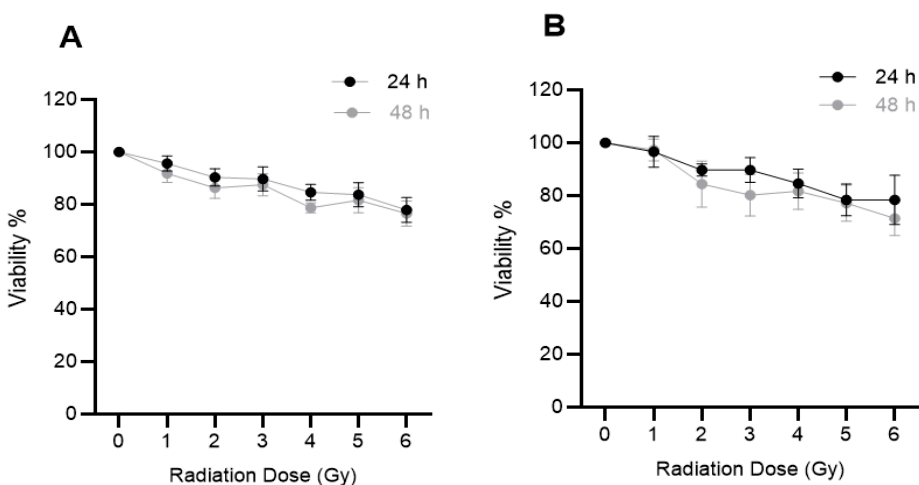
Figure 3. E ff ect of ionizing radiation (IR) on the viability of human cancer cells in vitro. ( A ) DU145 (prostate) and ( B ) A549 (lung) cancer cells were irradiated with 0–6 Gy X-rays and cell viability (viability %) was determined after 24 h or 48 h using the MTS assay. Results expressed as the mean ± SEM of 3 replicates.